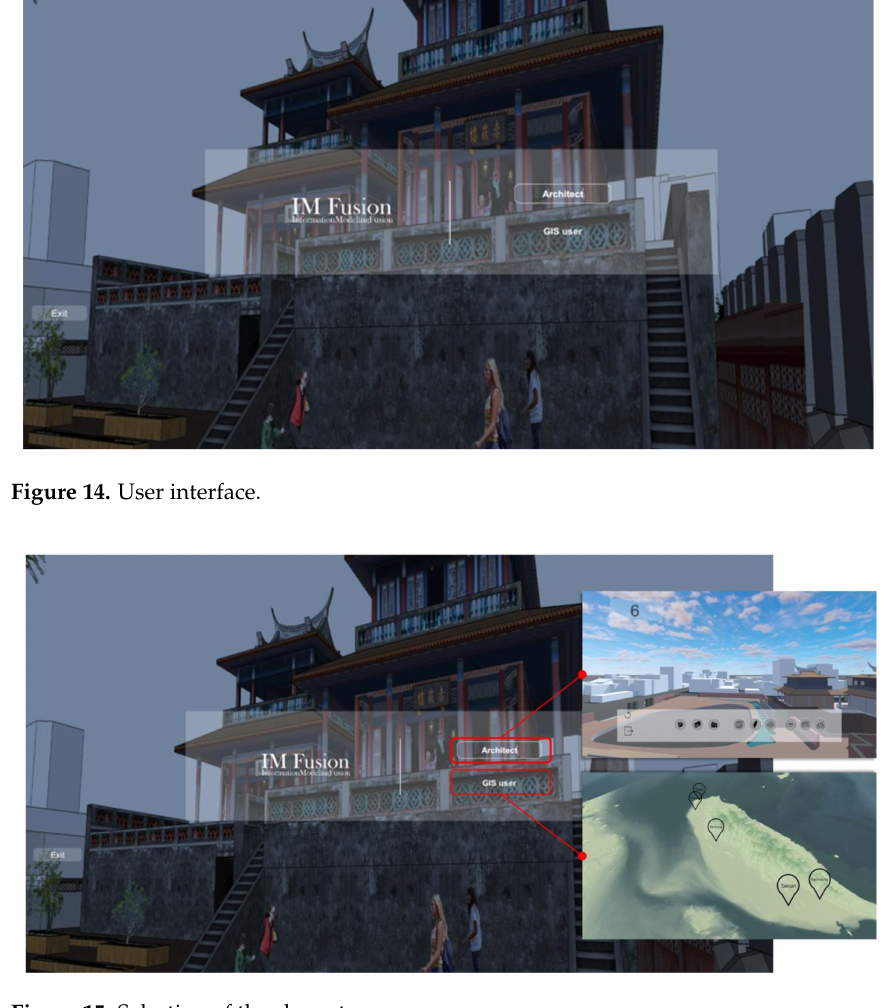
Figure 15. Selection of the character scene.